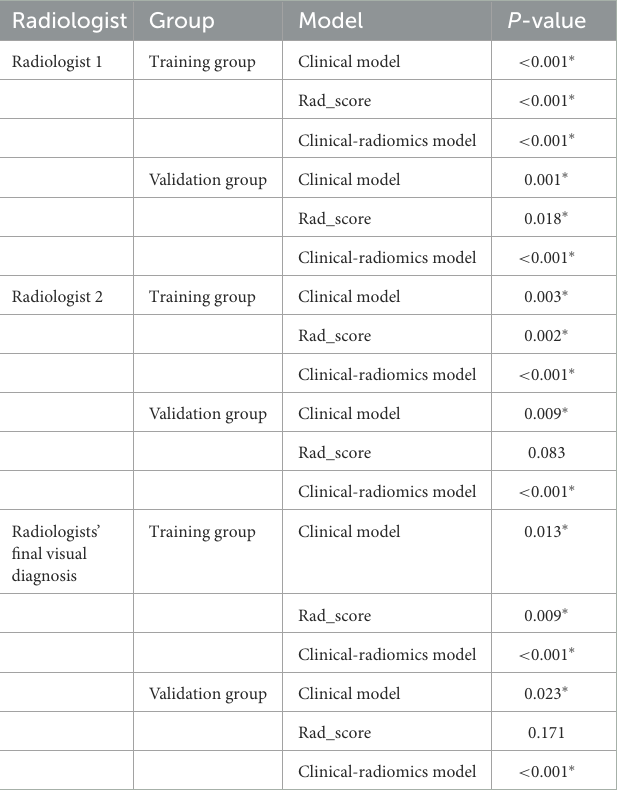
TABLE 4 Comparison of discriminative performance between radiologists’ visual diagnosis and models. Radiologist Group Model P